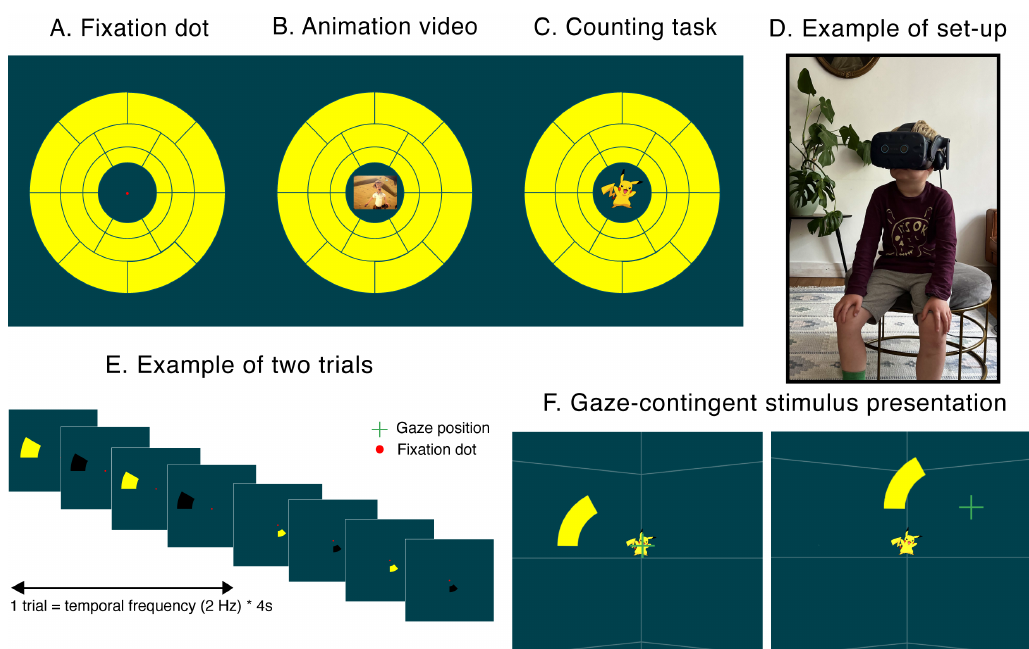
Figure 1. The three fixation target conditions used in this study; a red fixation point (A), an animation video (B), and a counting task (C). Children were seated in a chair where the headset was positioned. A picture of a participant at home (6 years old) is shown in (D). All fixation targets were displayed at a fixed position in the middle of a dark blue virtual reality environment. The 2 Hz flickering yellow-and black stimuli consecutively appeared at the 20 stimulus locations (E). To ensure accurate retinotopic stimulation stimuli were presented in a gaze-contingent manner (F), i.e., online correction of stimulus locations for saccades from fixation target. Note that thin white lines were added to the background to create a sense of depth in the virtual reality environment. Note that the green gaze position cross was not shown during the experiment but is here shown to illustrate the gaze-contingent presentation